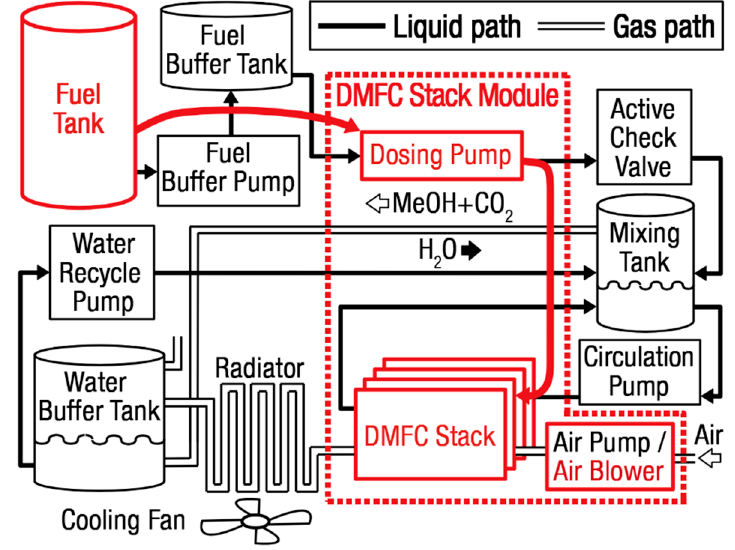
Figure 1. Comparing full balance of plant (BOP) components in an active direct methanol fuel cell (DMFC) stack system with that of a semi-active system marked in red, where a DMFC stack module is enclosed by the red dashed line.